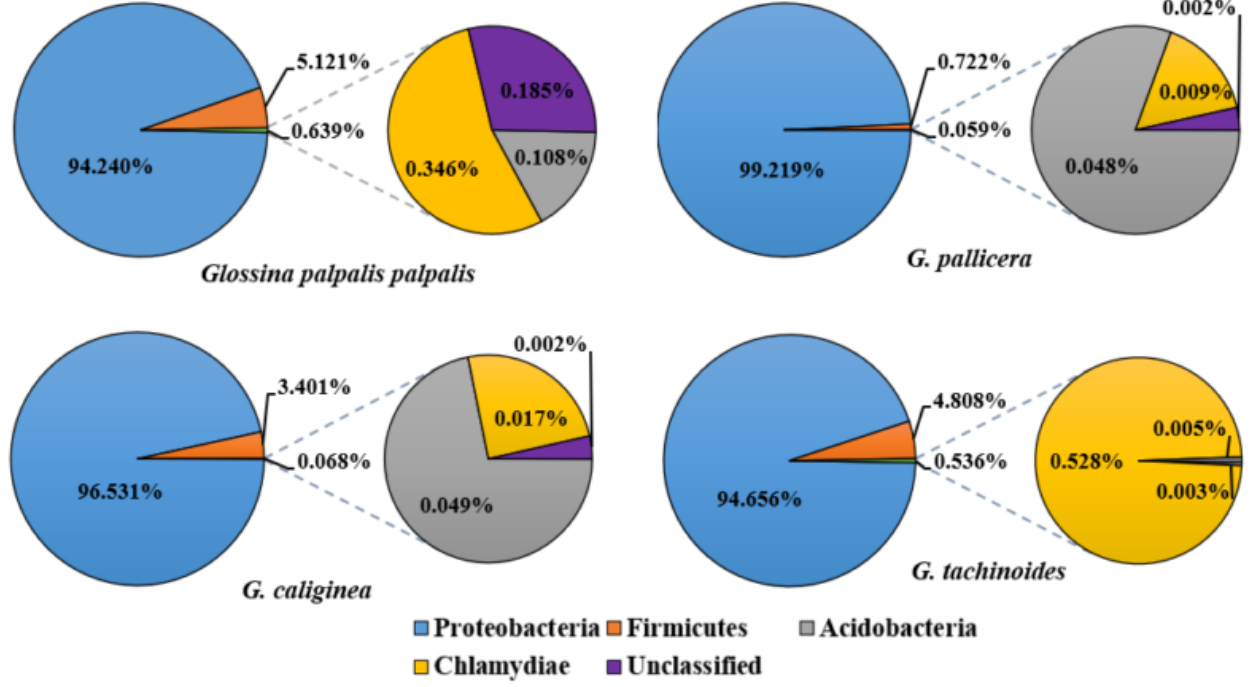
Figure 2. Relative abundance of bacterial phyla in tsetse